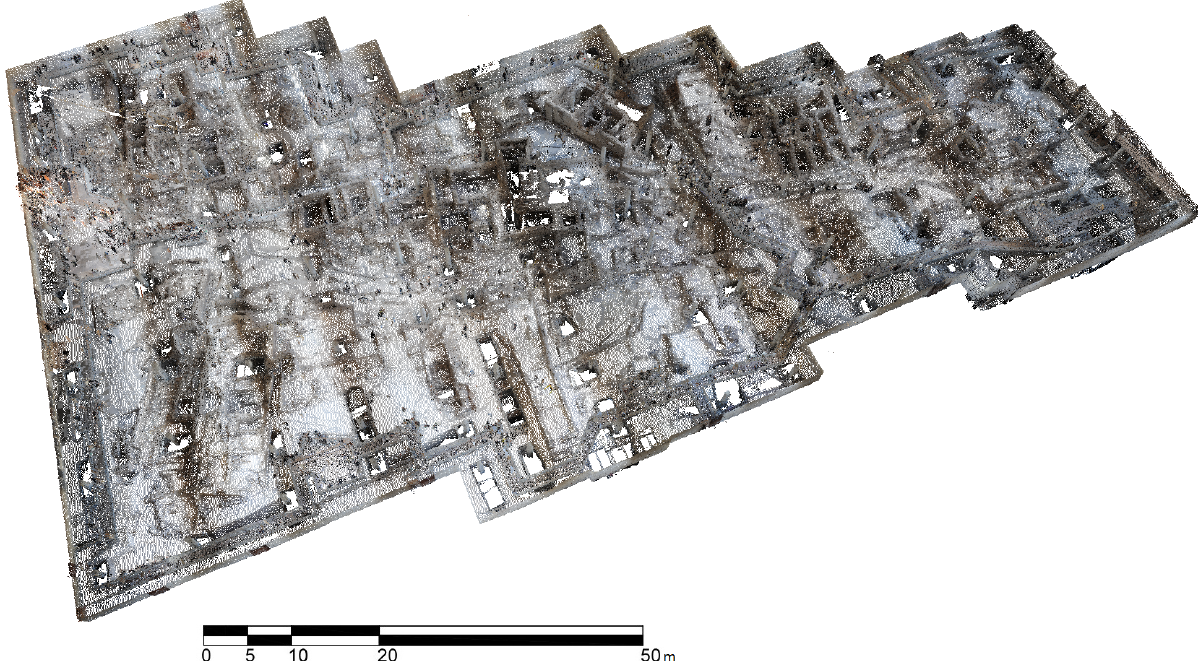
Figure 6: Overview of the reduced laser scanning data acquired across the entire excavated site of Akrotiri. Holes in the data equal the areas where modern pillars were erected to support the protective shelter. In the centre, in Complex Delta the roof had collapsed in 2005. Therefore, two rooms could not be accessed there, as well as one room in